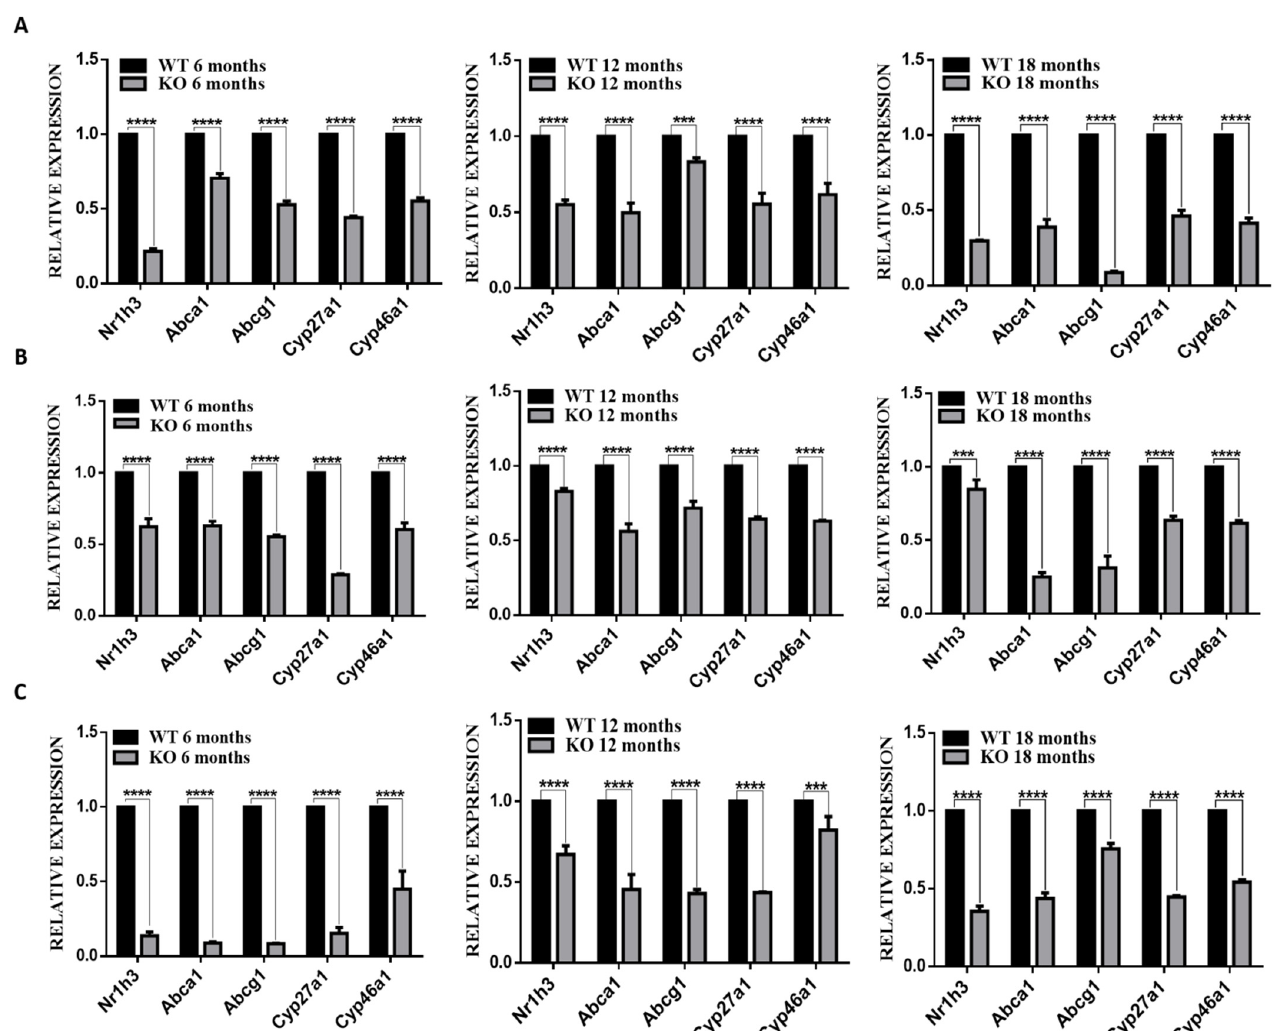
Figure 4. The expression of cholesterol homeostasis genes: Nr1h3 , Abca1 , Abcg1 , Cyp27a1 and Cyp46a1 in RPE/choroid/sclera ( A ), retina ( B ) and brain ( C ) of wildtype (WT) and Tspo KO mice at 6, 12 and 18 months old. The qRT-PCR data were collected as ct (Cycle threshold) values and normalised to Gapdh then analyzed by 2 − ∆∆ CT formula. The fold changes of each gene were presented as means ± SD and analyzed by two-way ANOVA with the appropriate post hoc test Bonferroni multiple comparisons tests ( n = 5). *** p < 0.001, **** p < 0.0001.